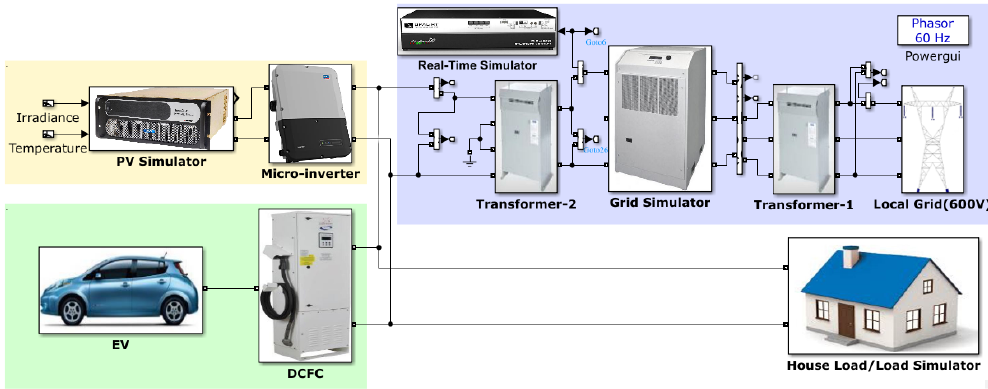
Figure 6. Simulink model of single-vehicle-based vehicle-to-home/grid (V2H/V2G).